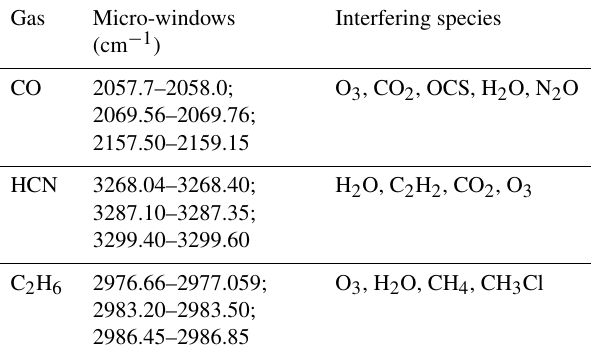
Table 3. Retrieval settings of gases to study the influence of WV. All interfering species are fitted with a scaling factor, except O 3 in the retrieval of CO and C 2 H 6 , and are fitted as vertical